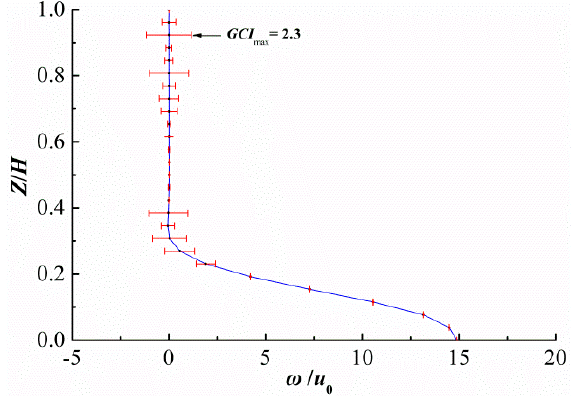
Figure 4. Vertical distribution of the grid convergence index (GCI) in jet orifice centerline.